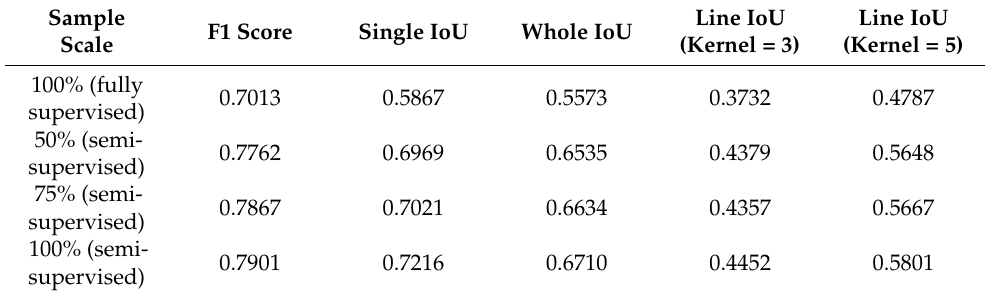
Table 3. Precision evaluation results for generalization ability analysis in SDLED.